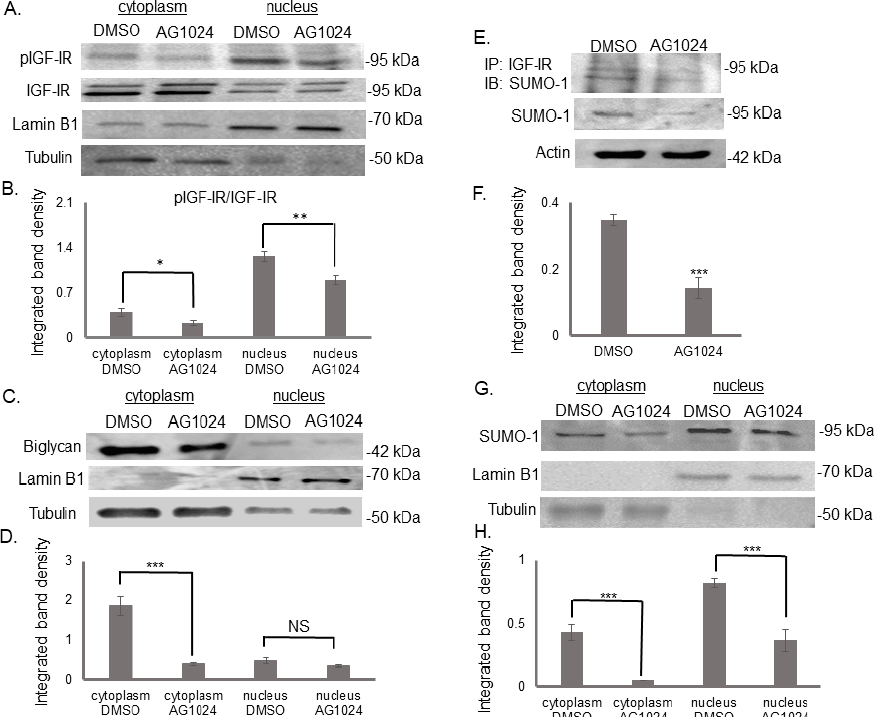
Figure 9. IGF-IR activation as an obligatory step of the mechanism. Expression of ( A ) pIGF-IR, ( C ) biglycan, and ( G ) SUMO-1 in the cytoplasmic compartment of the cells treated with DMSO in 0% FBS-medium (cytoplasm DMSO) and cells treated with AG1024 10 μ M (cytoplasm AG1024), as well as the nuclear compartment of the cells (nucleus DMSO; nucleus AG1024) were determined by Western blot analysis. Purity controls tubulin and lamin B1 were used for cytoplasmic and nuclear proteins, respectively. ( E ) Cells extracts were incubated with IGF-IR antibody overnight in a rotating platform and IGF-IR complexes were immunoprecipitated with Protein A/G. Western blot analysis was used for the visualization of SUMO-1 protein immunoprecipitation with IGF-IR. Equal amounts of protein were loaded and ( B , D , F , H ) densitometric analysis was performed and plotted. Representative blots are presented. Results represent the average of three separate experiments. Means ± S.E.M were plotted; statistical significance: * p ≤ 0.05, ** p ≤ 0.01, *** p ≤ 0.001, not statistically significant (NS) compared with the respective control samples.